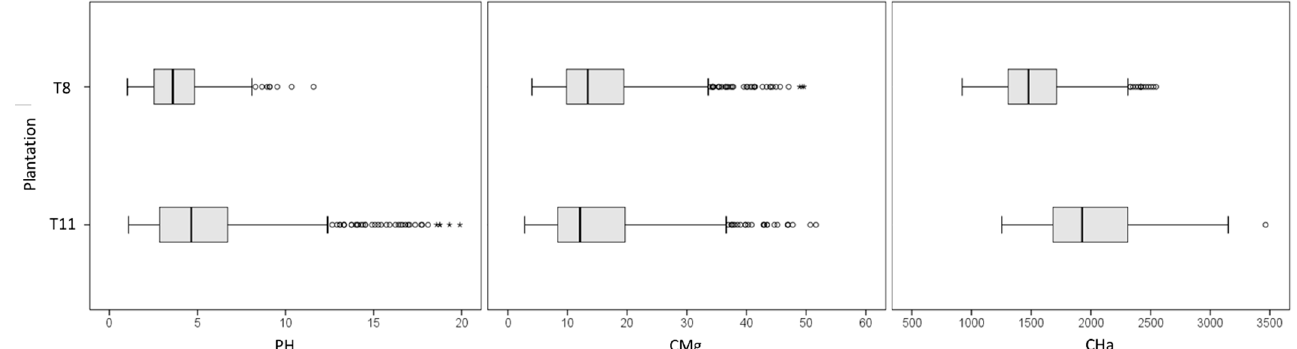
Figure 7. Box plots showing the comparison of data distributions of PH (work productivity), CMg (unit cost), and CHa (cost per hectare) in plantations T8 and T11.